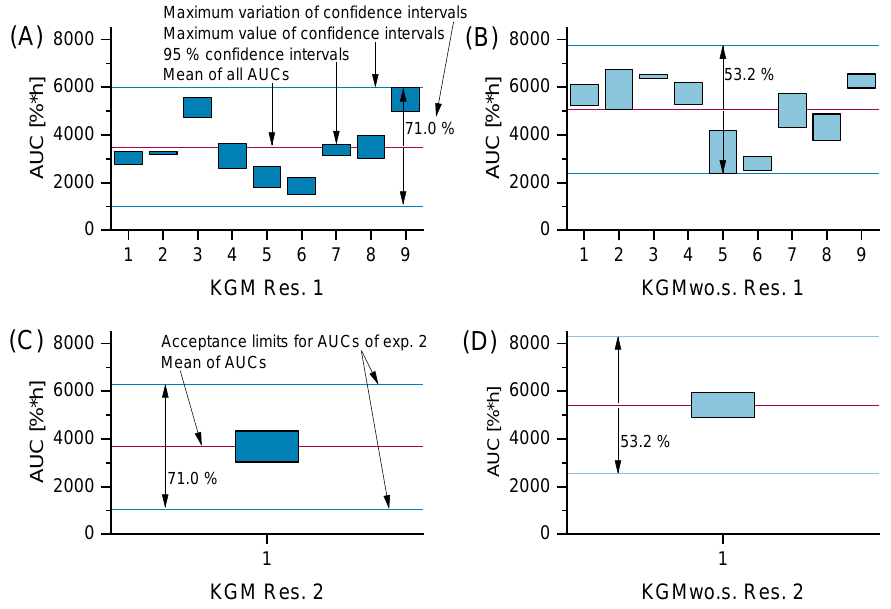
Figure 3. Intralaboratory variance of the DED wound healing model with an equivalence test; ( A , B ) the maximal variation of the confidence intervals of researcher 1 (Res. 1) was used to determine a relative variability of 71.0% for KGM and 53.2% for KGMwo.s.; nine independent experiments were conducted; Res. 1 analyzed 33–34 wells per sample in those nine experiments (n well Res. 1 = 33–34); ( C , D ) the same relative variability was applied to the mean of the AUCs of KGM and KGMwo.s. of researcher 2 (Res. 2) to define the cutoff values for the confidence intervals of Res. 2 to be considered tolerable (n well Res. 2 =